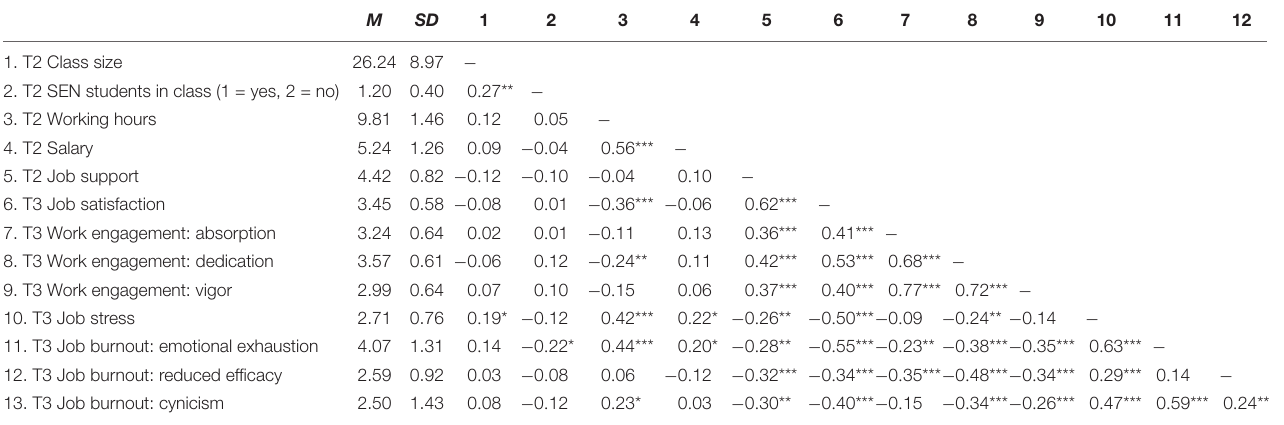
TABLE 1 | Means, standard deviations, and bivariate correlations between occupational well-being (OWB) indicators for the total